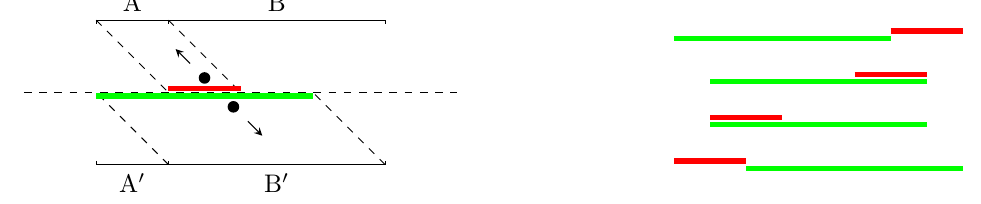
Figure 8 . Quasi-particle interpretation of results in eq. (2.27). Left: quasi-particle in thermal (cid:12)eld double states. Initially each pair of degrees of freedom in the left and right form an EPR pair. The entanglement is proportional to the overlap of past the light cones. Right: the overlap of the past light cones of A (red) and B 0 (green) in di(cid:11)erent stages. Figure shows those turning